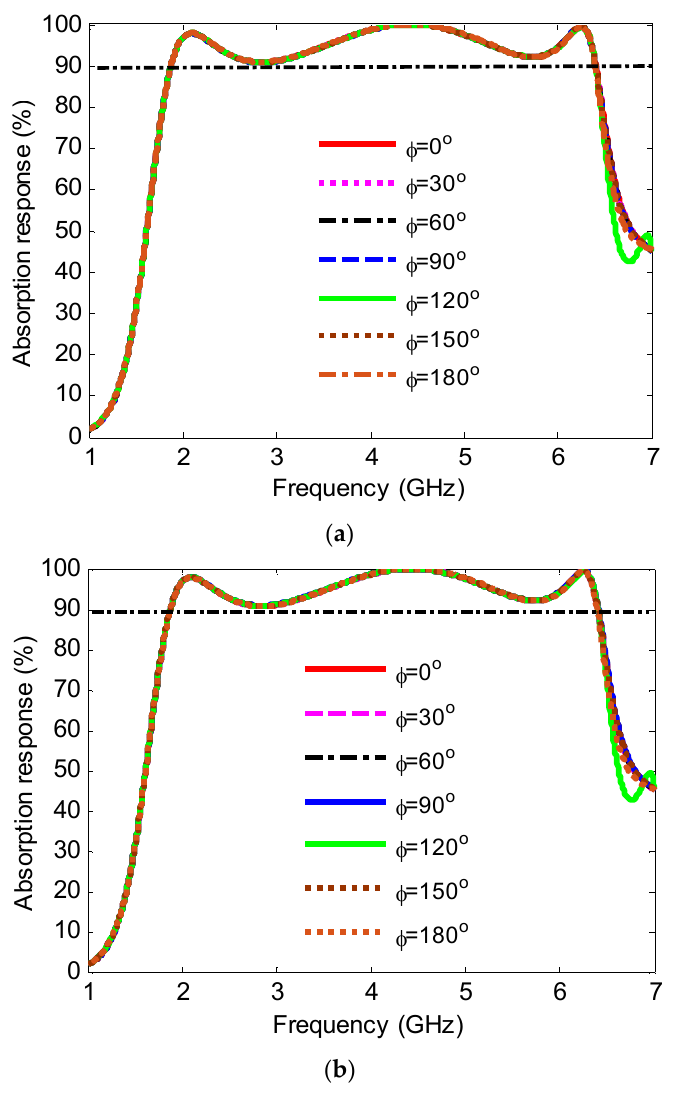
Figure 7. Simulated absorption ratio for various polarization angles: ( a ) TE-polarized and ( b ) TM- polarized.